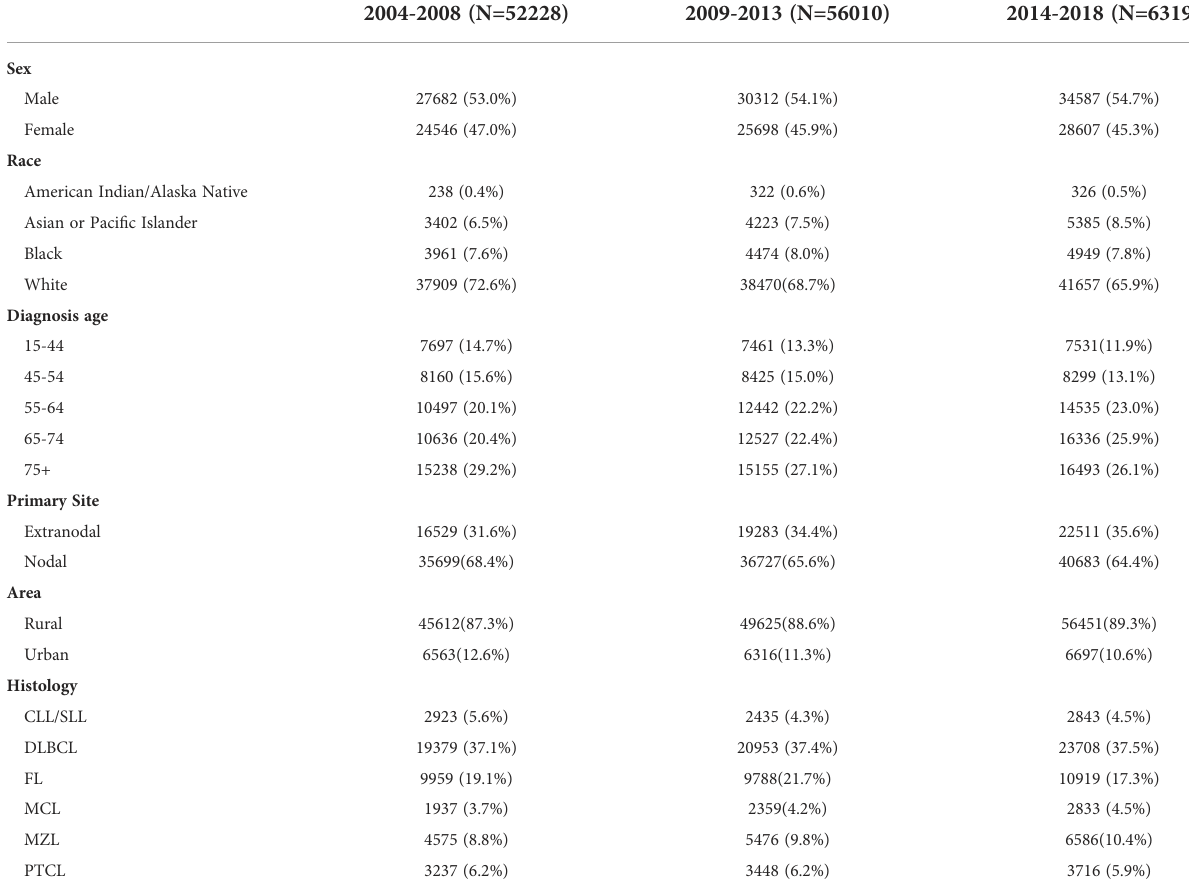
TABLE 1 2004 – 2018 Basic Situation of Non-Hodgkin lymphoma